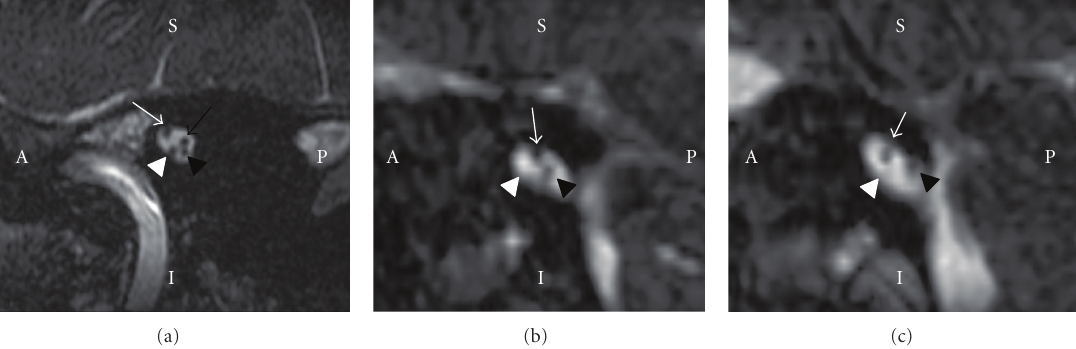
Figure 1: (a) Normal sagittal oblique 3D CISS MR Image perpendicular to the fundus of the internal auditory canal. The anterior (A), posterior (P), superior (S), and inferior (I) aspects of the canals are labeled for ease of orientation. The facial (white arrow), superior vestibular (black arrow), inferior vestibular (black arrowhead), and the cochlear nerves (white arrowhead) are depicted. (b) Right Ear agenesis of the cochlear nerve. (c) Left Ear agenesis of the cochlear nerve. Note on the sagittal oblique section the facial nerve in the anterosuperior quadrant (white arrow). Only one vestibular nerve is seen in the posterior quadrant (black arrowhead), showing incomplete separation of the superior and inferior vestibular nerves. The cochlear nerve is absent in the anterior inferior quadrant (white